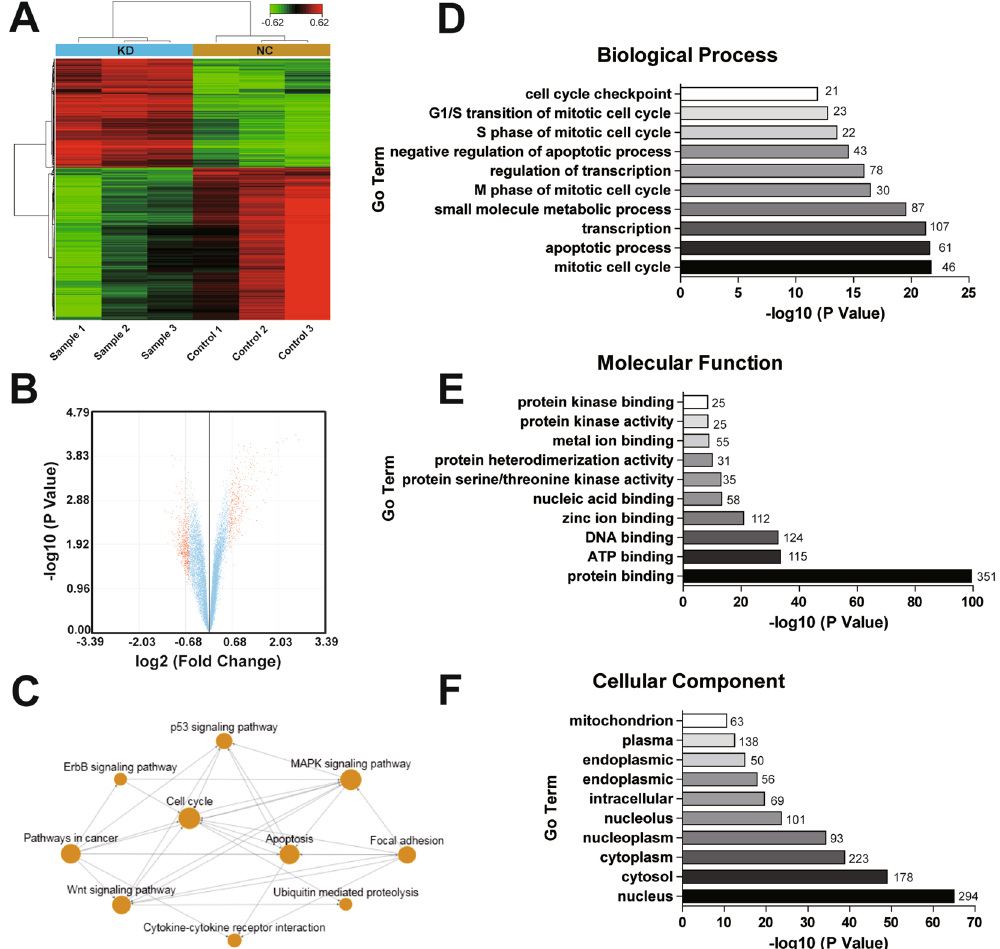
Figure 4. RAD51-AS1 knockdown regulates gene expression in SKOV3.ip cells. ( A ), Hierarchical clustering of the genes differentially expressed in SKOV3.ip cells 24 hours after RAD51-AS1 silencing. Each column represents one sample and each row represents one gene. The color scale at the top of the figure illustrates the relative expression of a gene across all of the samples, with red indicating high expression and green indicating low expression. ( B ), Volcano plot shows that some genes were differentially expressed after RAD51-AS1 knockdown. ( C ), Analysis of pathway relation network. The interactions in the KEGG Database were used to construct the interaction network between pathways, and the top ten pathways after silencing RAD51-AS1 are shown. ( D , E and F ), The significant analysis of Gene Ontology (GO) on three aspects (D, biological process analysis; E , molecular function analysis; F, cellular component analysis) were performed with parameter settings of P = 0.05, FDR = 0.05, and the top ten terms are